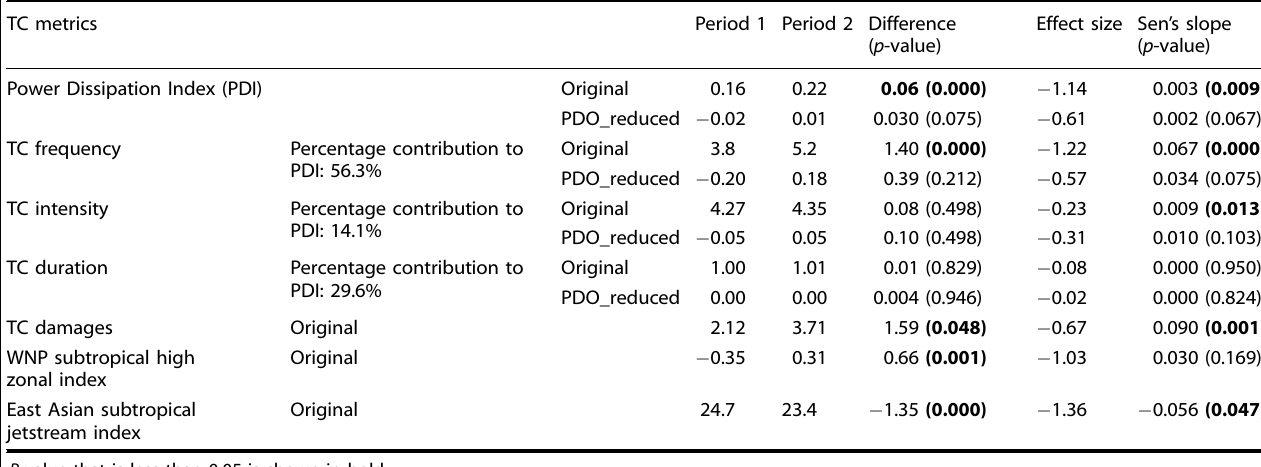
Table 1. Trend and shift of indicated TC metric and index and when the in fl uence of the PDO is reduced from their respective